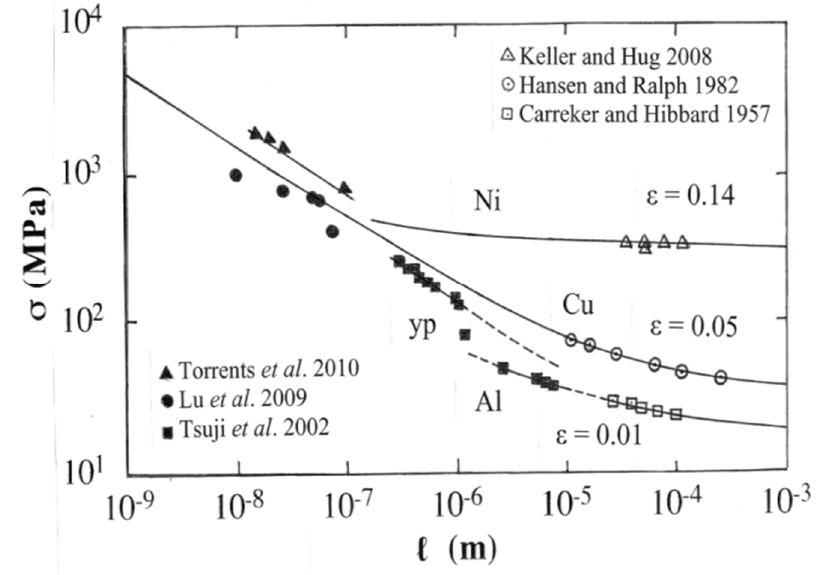
Figure 2. Comparison at conventional and ultrafine grain sizes of H-P measurements for aluminum, copper and copper and nickel.